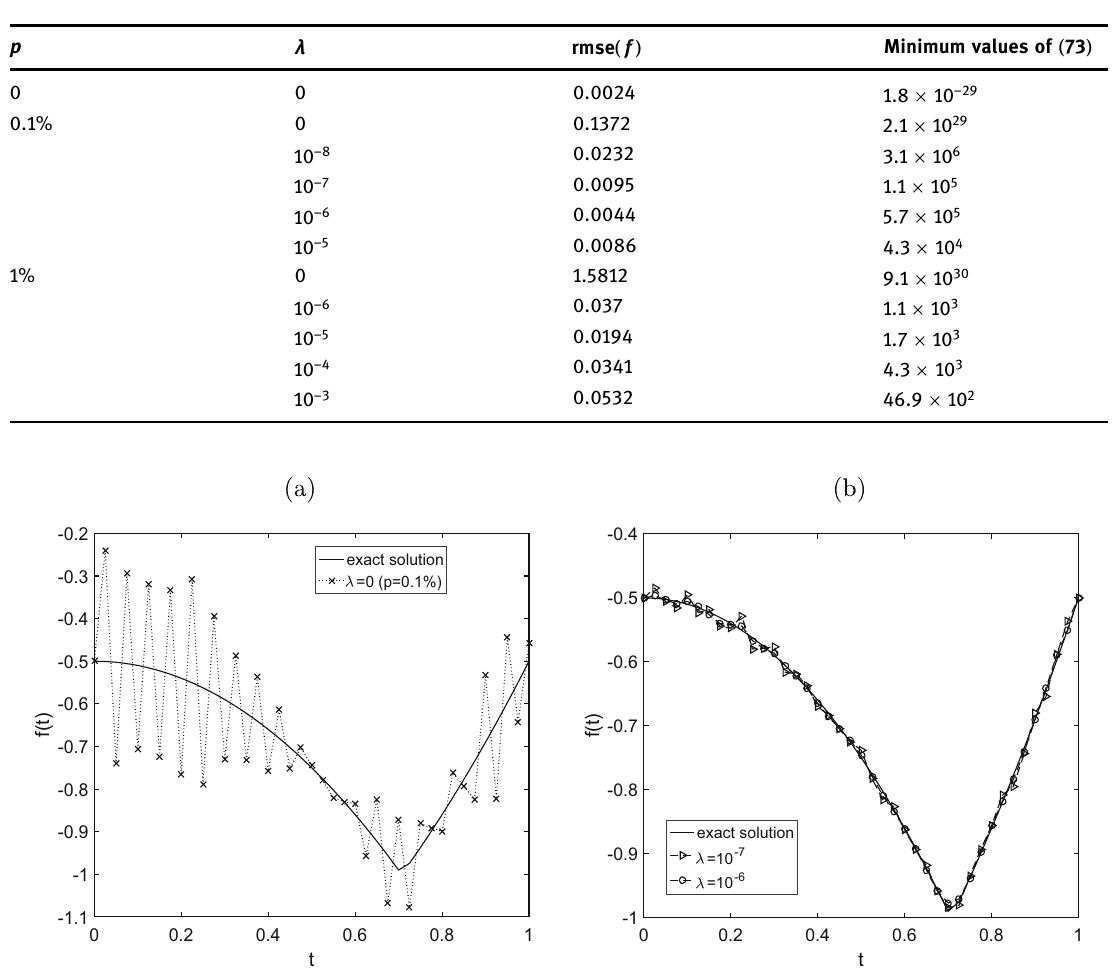
Figure 8: The exact ( 89 ) and approximate ( ) f t , for = p 0.1% with λ : ( a ) 0 and ( b ) 10 , 10 −7 −6 , for Example